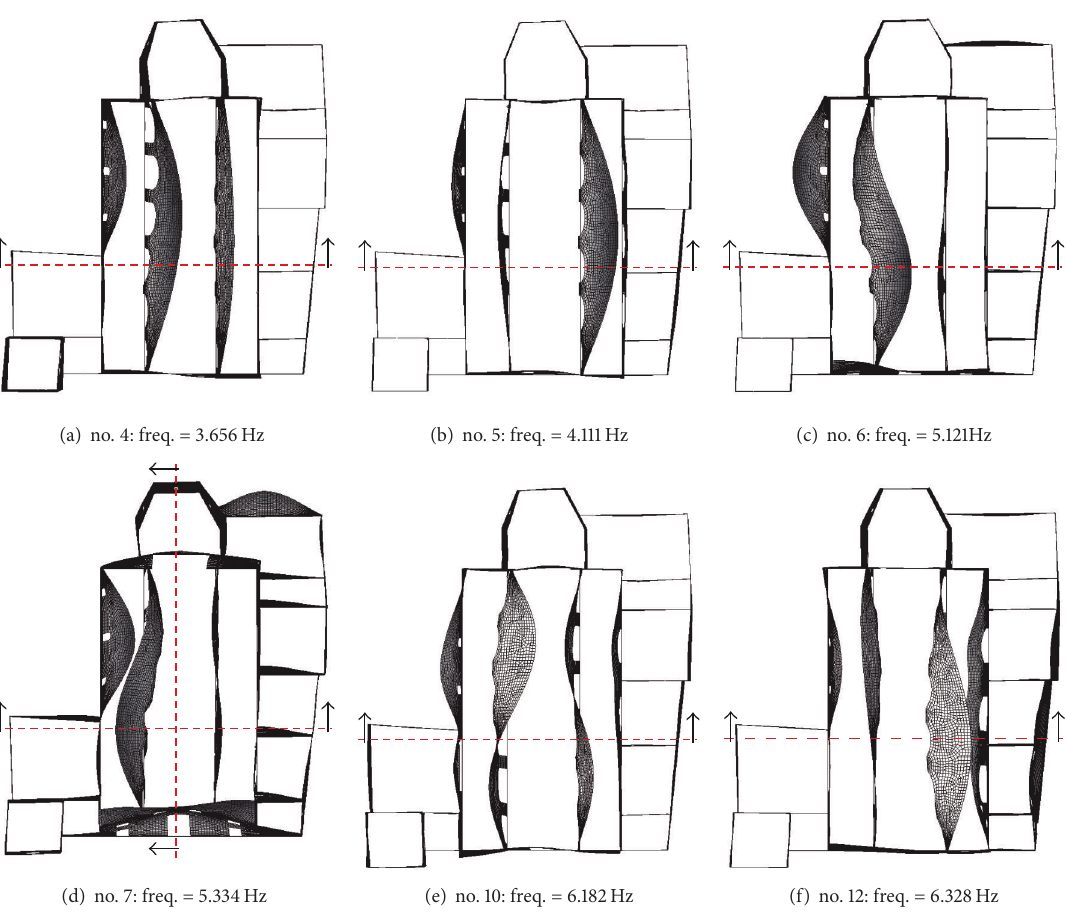
Figure 6: Linear dynamic analysis: horizontal section of the horizontal section of the main six eigen-modes. Vaults and roof structures are hidden to